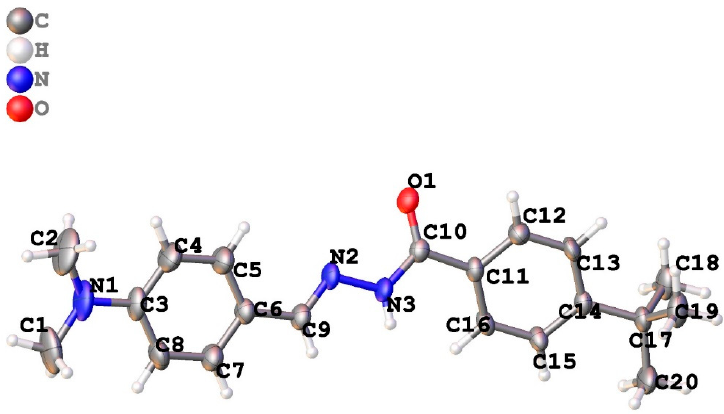
Figure 3. Molecular Structure of compound 14 .